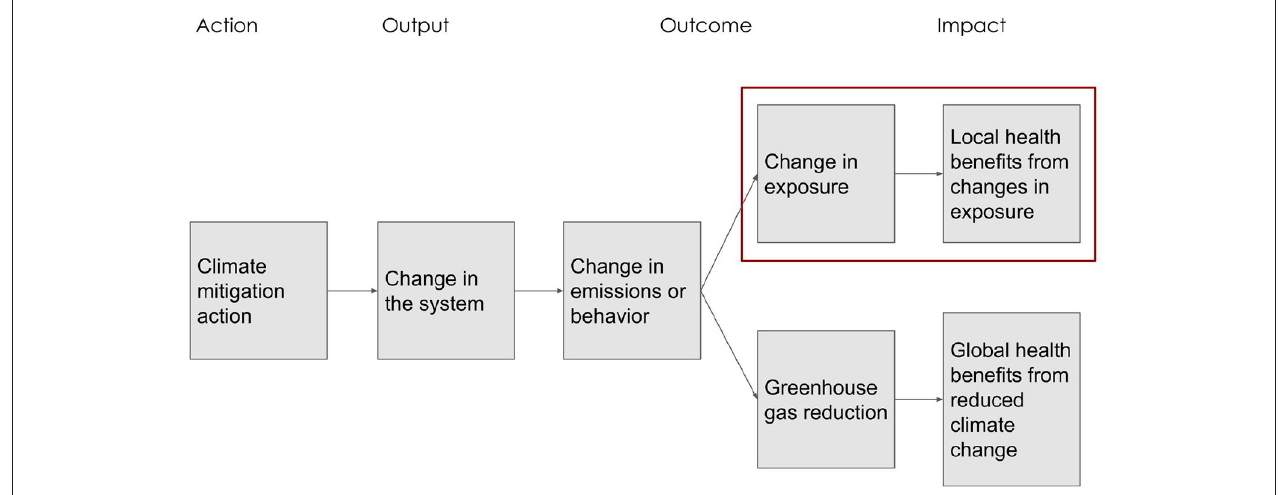
FIGURE 1 | Framework linking mitigation actions and health benefits in cities. The boxes outlined in red are the subject of the current paper.